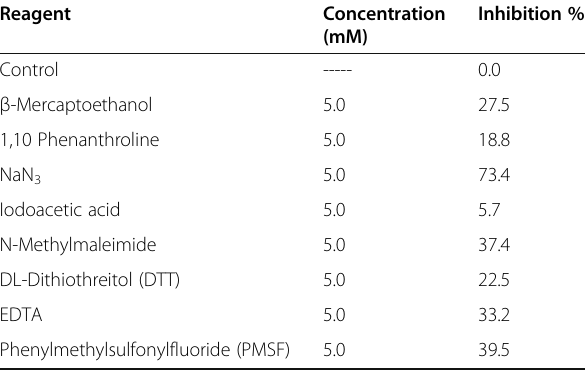
Table 3 Effect of various inhibitors on Egyptian honey bee venom PLA2 Reagent Concentration